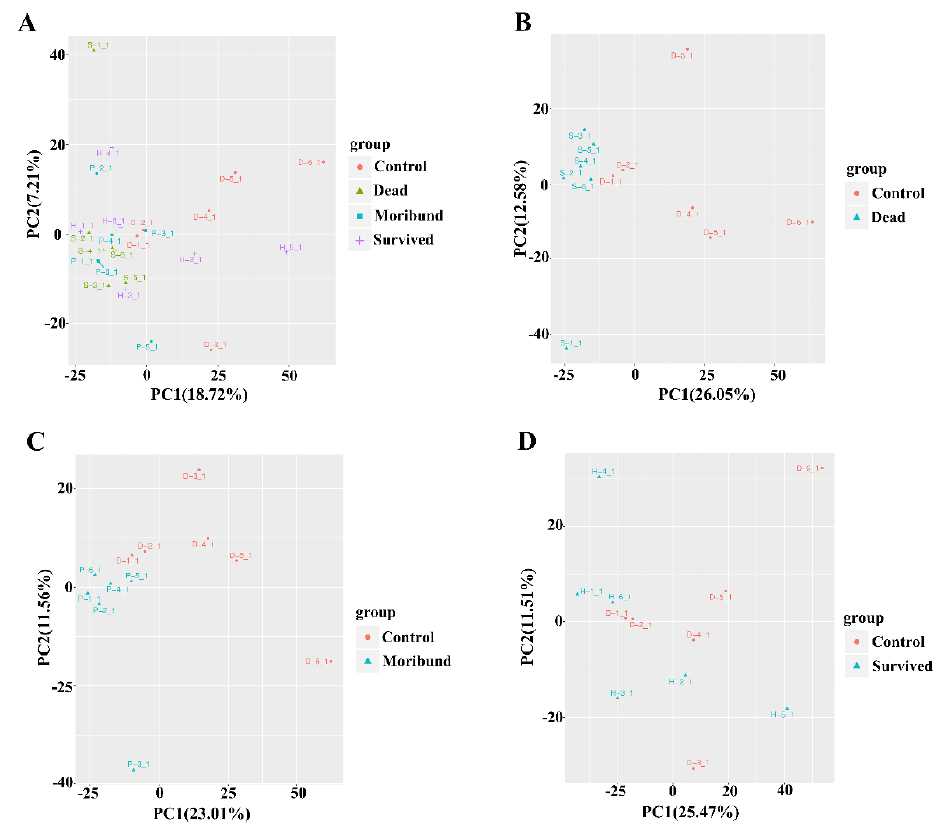
Figure 1. PCA analysis of all the samples ( A ). PCA analysis of specific samples from dead group ( B ), moribund group ( C ), and survived group ( D ) of Macrobrachium nipponense .